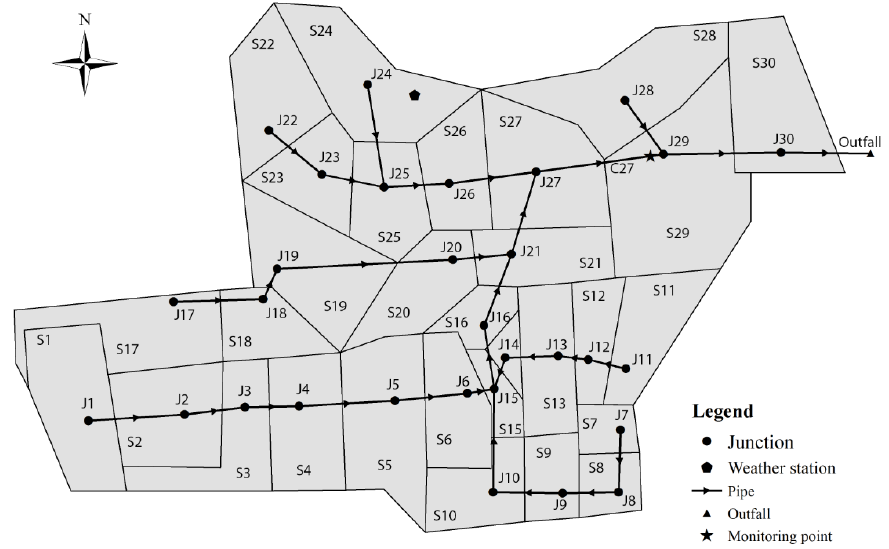
Figure 1. The stormwater management model (SWMM) model configuration for the study area including 30 sub ‐ catchments (S1–S30), 30 junctions (J1–J30), underground pipes (thick solid lines with arrows for flow directions), monitoring point, and weather